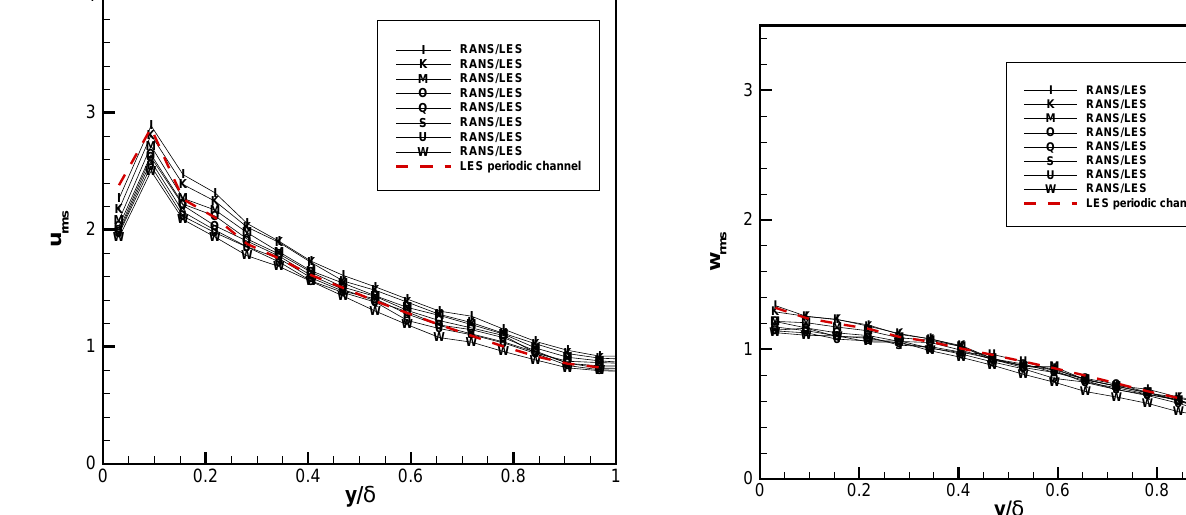
Fig. 8. Comparison of the spanwise rms profile. Red dashed line: reference results from the periodic channel simulation; black lines: span-wise rms profile at different sections of the channel with the buffer region.